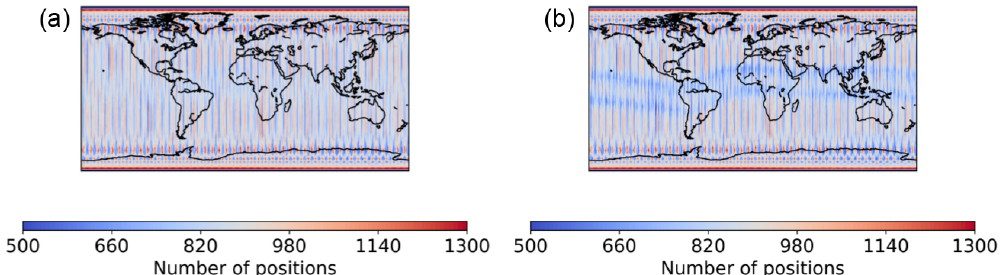
Figure 13. Number of kinematic positions for the analyzed test period. 2015: January, March; 2016: February, March, June, July, August, unscreened (a) and with AIUB standard screening (b) . Binned in a 1 ◦ × 1 ◦ grid.